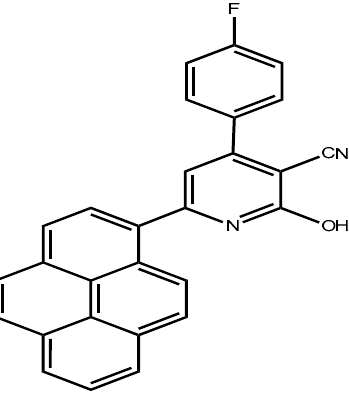
Figure 1. Structure of probe ESIPT-F.